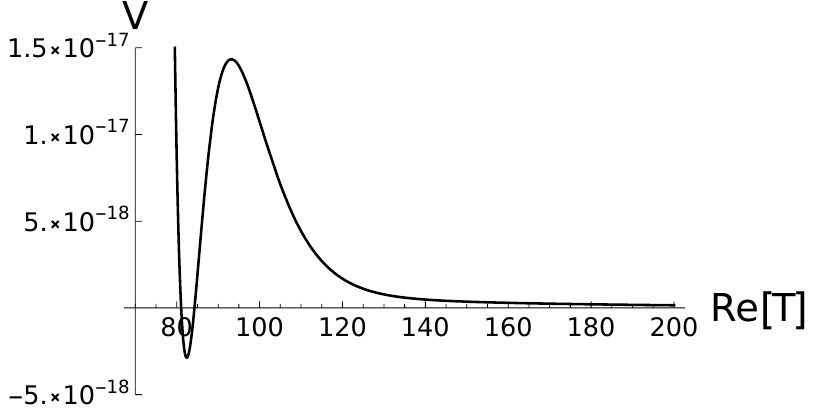
Figure 1 . A plot of the W 0 = 0 case (Case 0) using the racetrack parameters from eq. (3.4). The nonperturbative correction results in an anti-de Sitter minimum. Because the potential asymptot- ically approaches zero from above, there must then be a maximum in T R between this minimum and in(cid:12)nity. That maximum is in fact very near to a de Sitter saddle